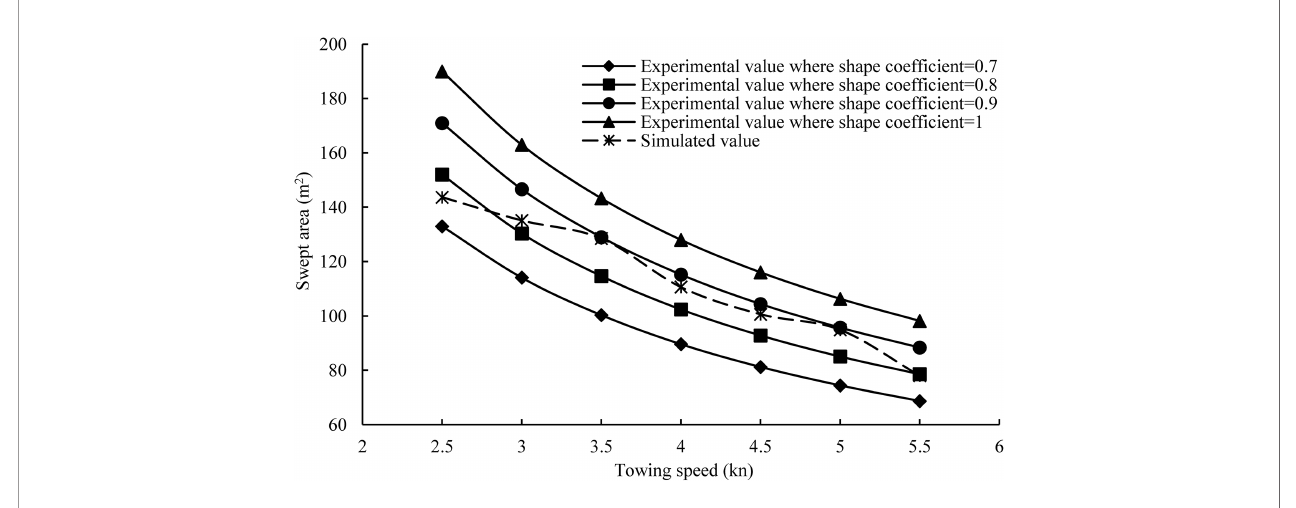
FIGURE 10 | Swept